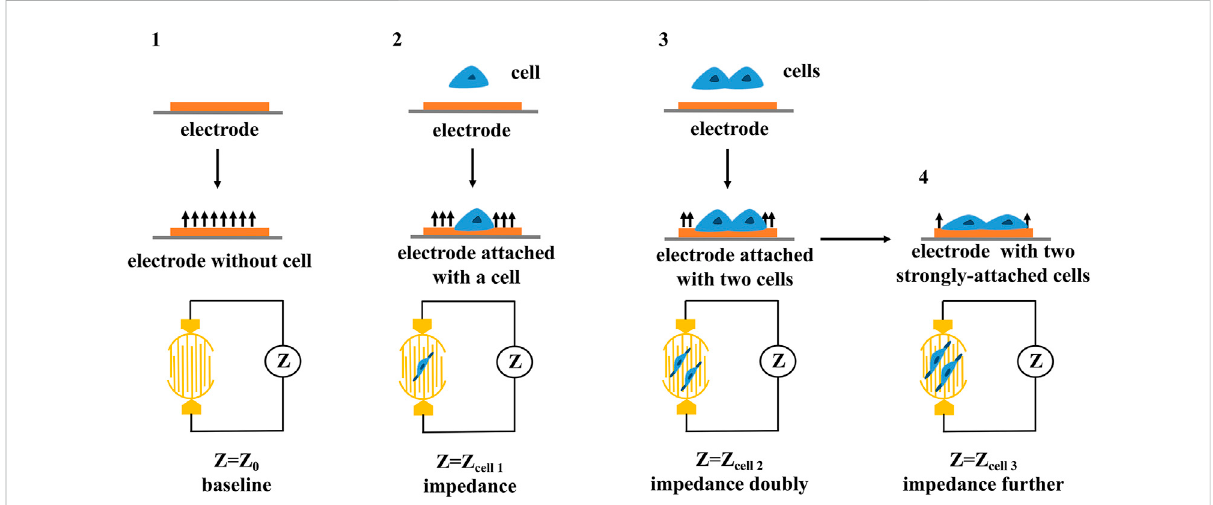
FIGURE 4 The principle of cellular impedance detection. The cell biological states including quantity, mass, size, attachment state can be re fl ected by the changes in